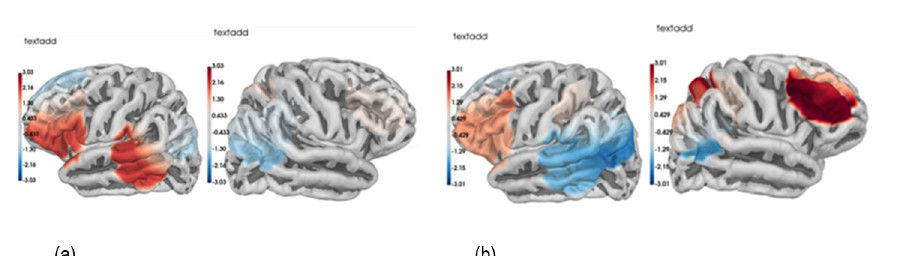
Figure 4. Activation associated with a word format of calculation task in (a) group with high level of math competencies, and (b) group with low level of math competencies